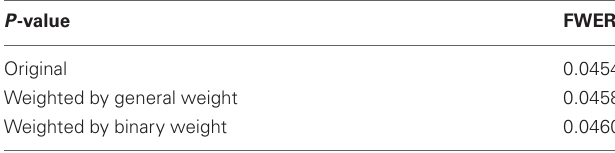
Table 4 | Family-wise error rate estimates in 5000